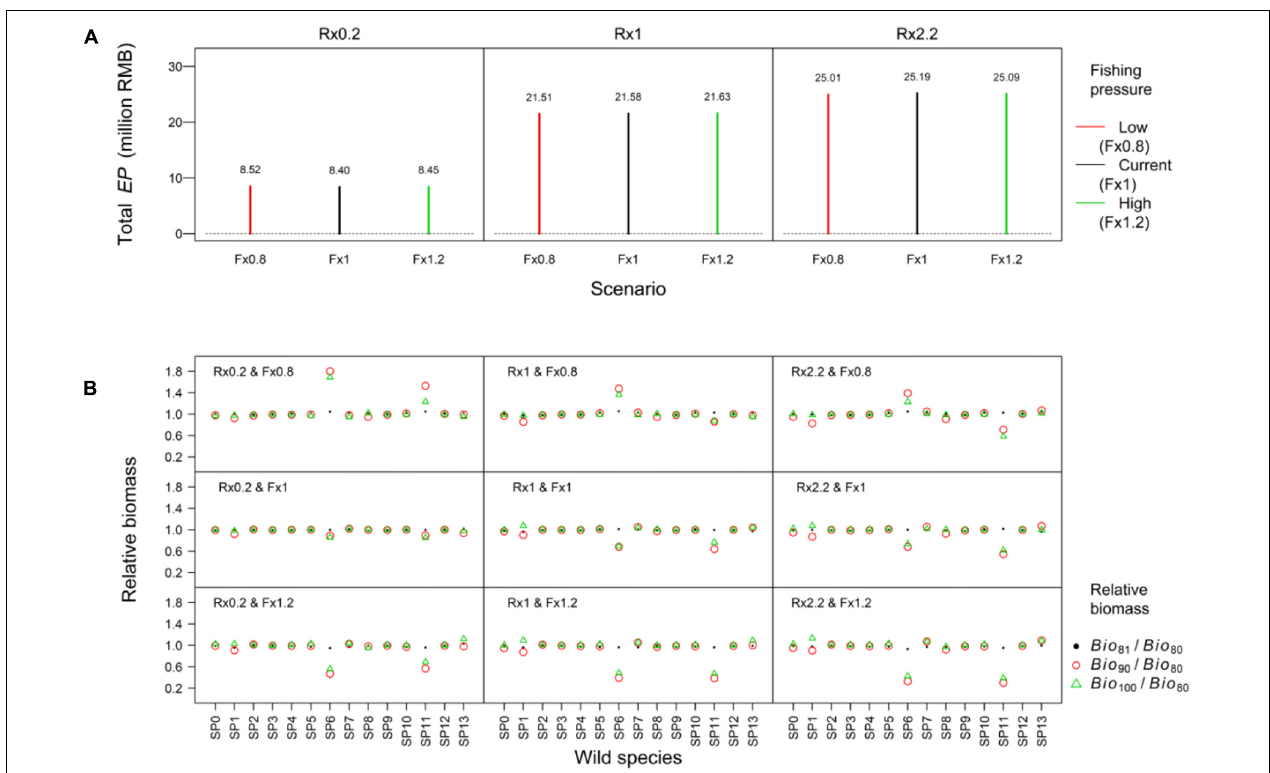
FIGURE 6 | The sum of economic profit in the release stage (Total EP ) (A) and variations of wild species biomass (B) in S3. The F. chinensis release implemented and fishing changed since 81st year. Since 91st year, the F. chinensis release stopped and fishing mortality rates of HTL groups were set the same to that in Xing et al. (2017) (current fishing pressure level). The Bio 80 , Bio 81 , Bio 90 , and Bio 100 were wild species biomass in the 80th, 81st, 90th, and 100th year, respectively. The calculation of indicators were shown in Table 2